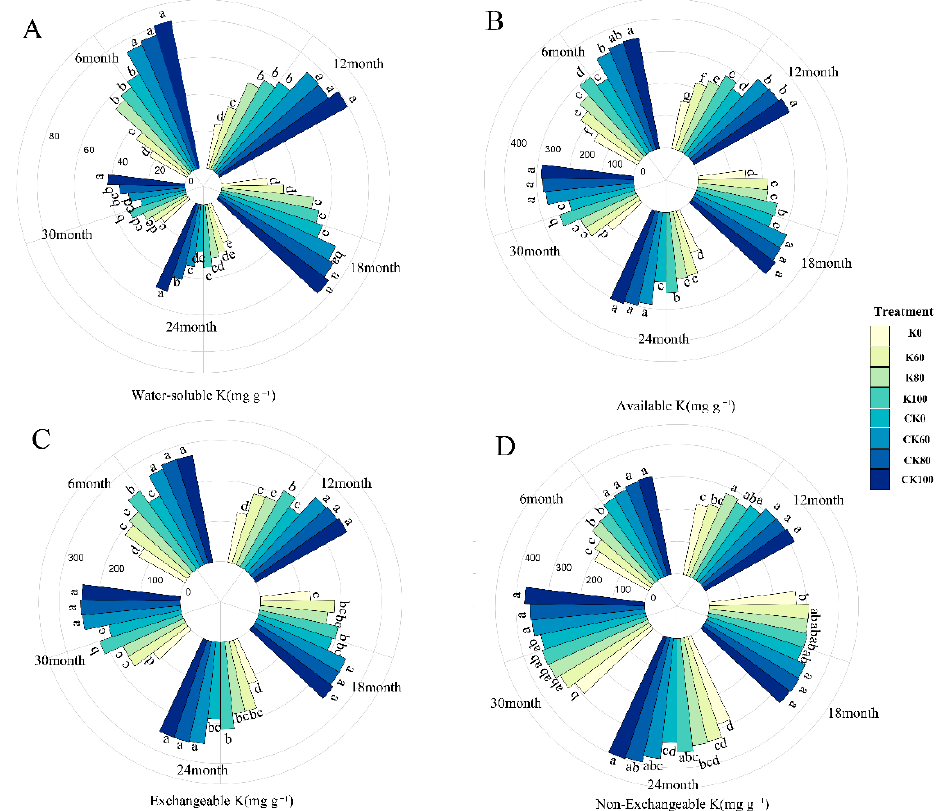
Figure 1. Water-soluble K ( A ), available K ( B ), exchangeable K ( C ), and non-exchangeable K ( D ) during the incubation under different biochar and K fertilizer treatments. (Sampling time: 6 months, 12 months, 18 months, 24 months, 30 months). Different lowercase letter indicate significant differences according to Duncan’s test ( p < 0.05).